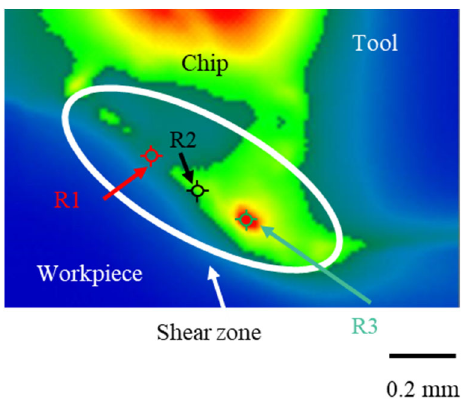
Figure 4. Example of a thermogram. R1, R2 and R3 represent 3 px × 3 px measurement points located along the shear zone. Cutting speed V c = 7.5 m/min and feed f = 0.4 mm.